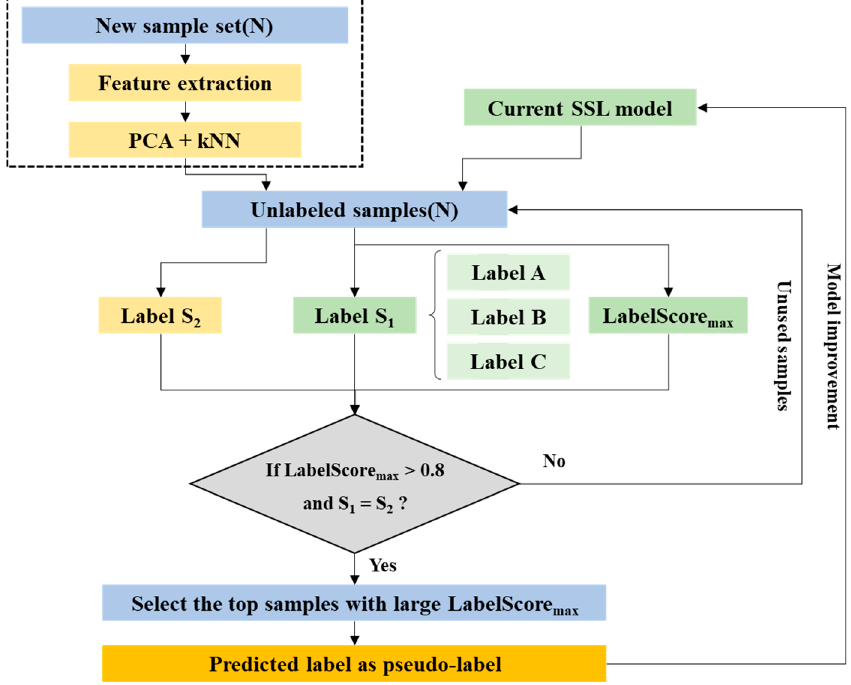
Figure 15. Proposed flowchart to optimize the IE data of concrete specimens.